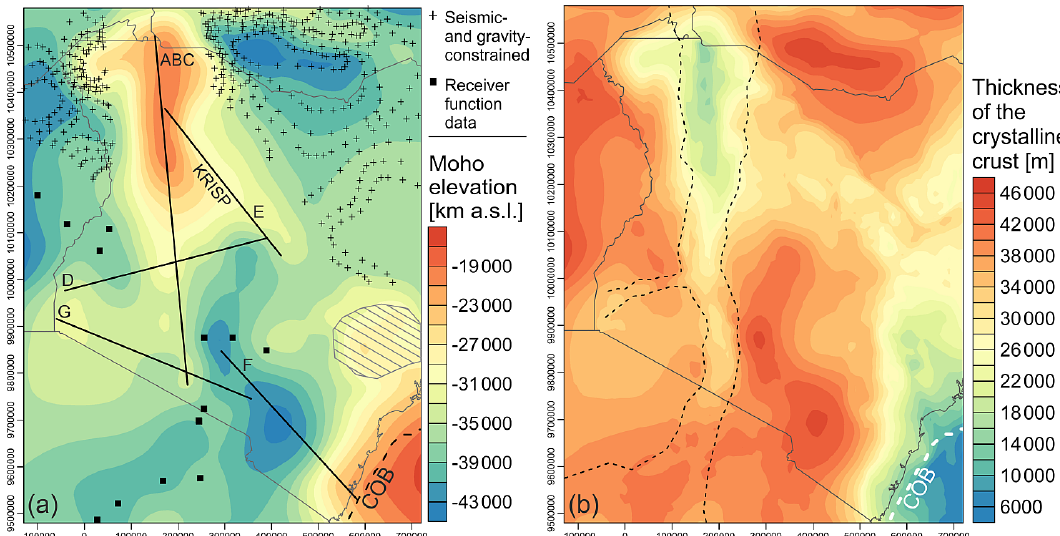
Figure 3. (a) Crust–mantle boundary (Moho); constraining data comprise the KRISP refraction seismic profiles (A–G; Khan et al., 1999), receiver function data (squares; Tugume et al., 2012, 2013), and a 3-D gravity-constrained model (crosses; Woldetinsae, 2005); the interpo- lation also integrated Moho depths in the oceanic crustal domain outside the study area as derived from LITHO1.0 (Pasyanos et al., 2014); the hatched area indicates where the Moho depth was interactively modified (moved upwards) according to the gravity response of the 3-D density model. (b) Thickness of the crystalline crust underlying the sedimentary and volcanic deposits as obtained by subtracting the depth to basement (Fig. 2a) from the Moho in (a) . COB – continent–ocean